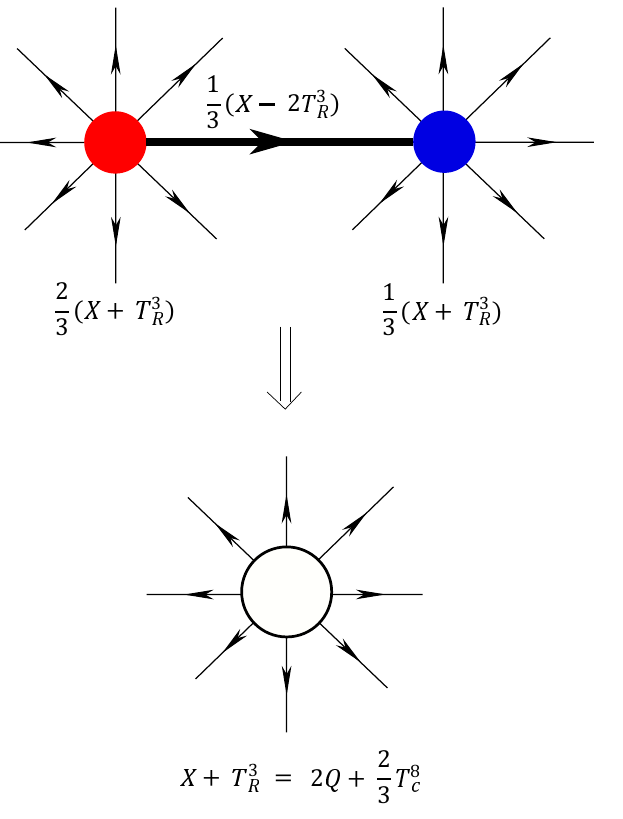
Figure 1 . Emergence of (Schwinger) magnetic monopole with two units of Dirac charge from the symmetry breaking SU(4) c SU(2) L SU(2) R SU(3) c U(1) B − L SU(2) L U(1) R × × → × × × → SU(3) c SU(2) L U(1) Y . This monopole also carries color magnetic charge. An SU(4) c (red) × × and an SU(2) R (blue) monopole are connected by a flux tube which pulls them together to form a Schwinger monopole. The magnetic flux along the tube and the Coulomb magnetic fluxes of the monopoles are indicated. Intermediate mass monopoles such as this one may survive